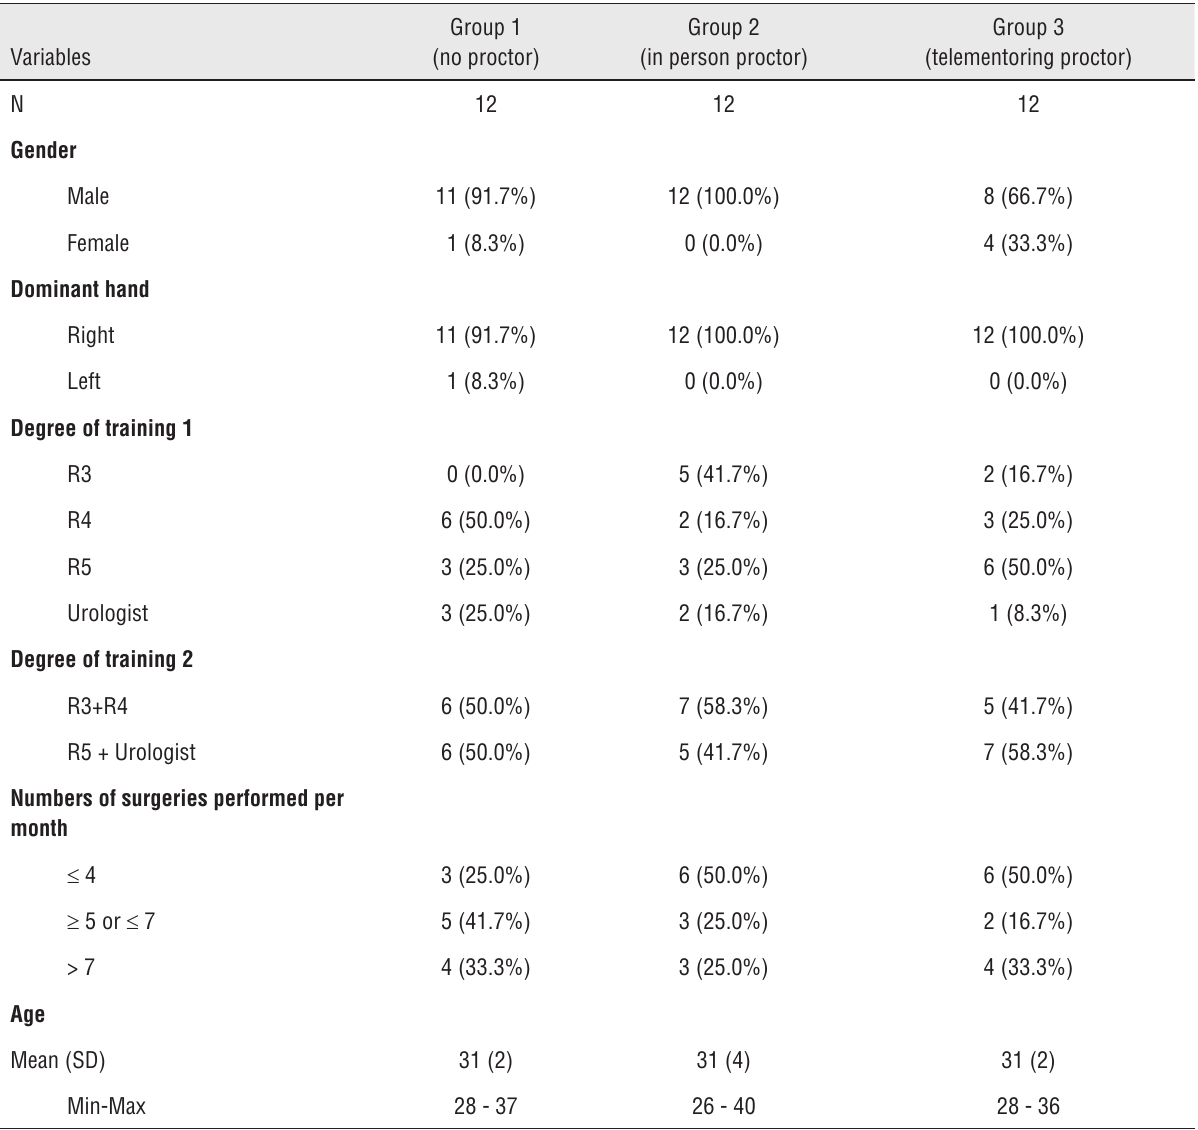
Table 1 - General characteristics of the participants according to